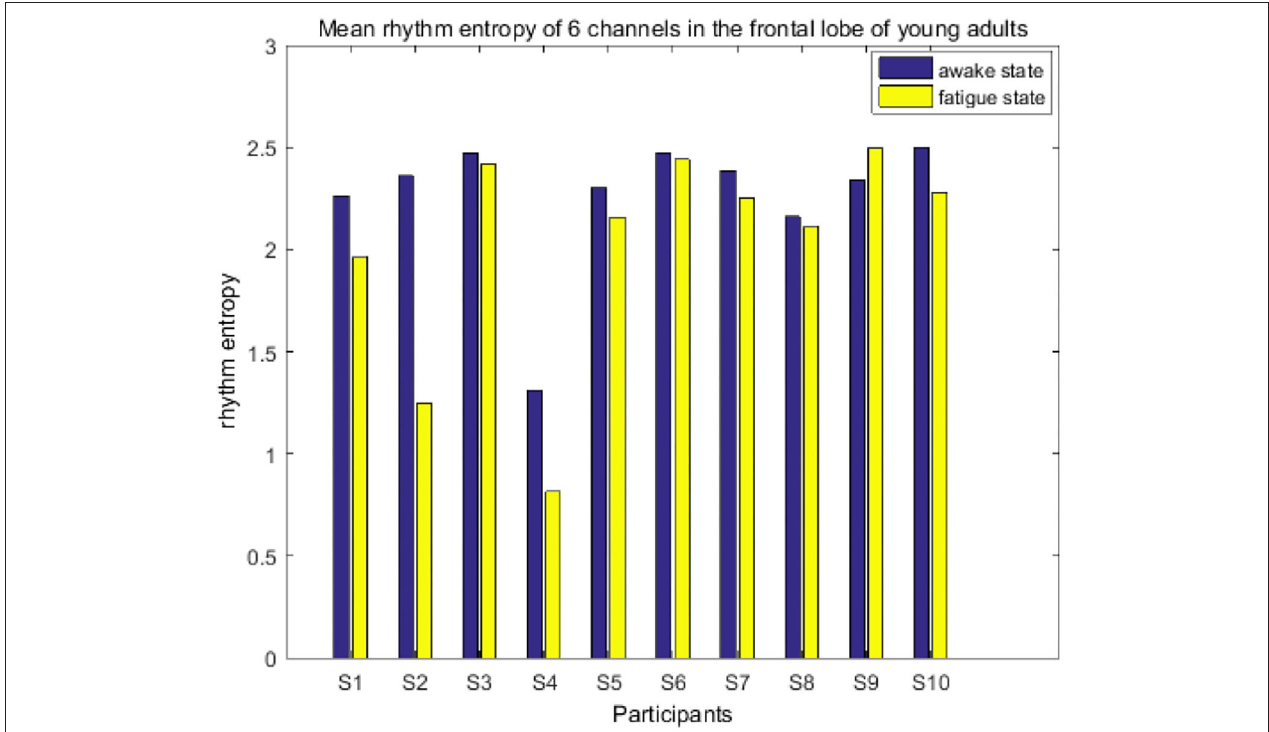
FIGURE 7 | Mean rhythm entropy of six channels on the frontal lobe of young adults.